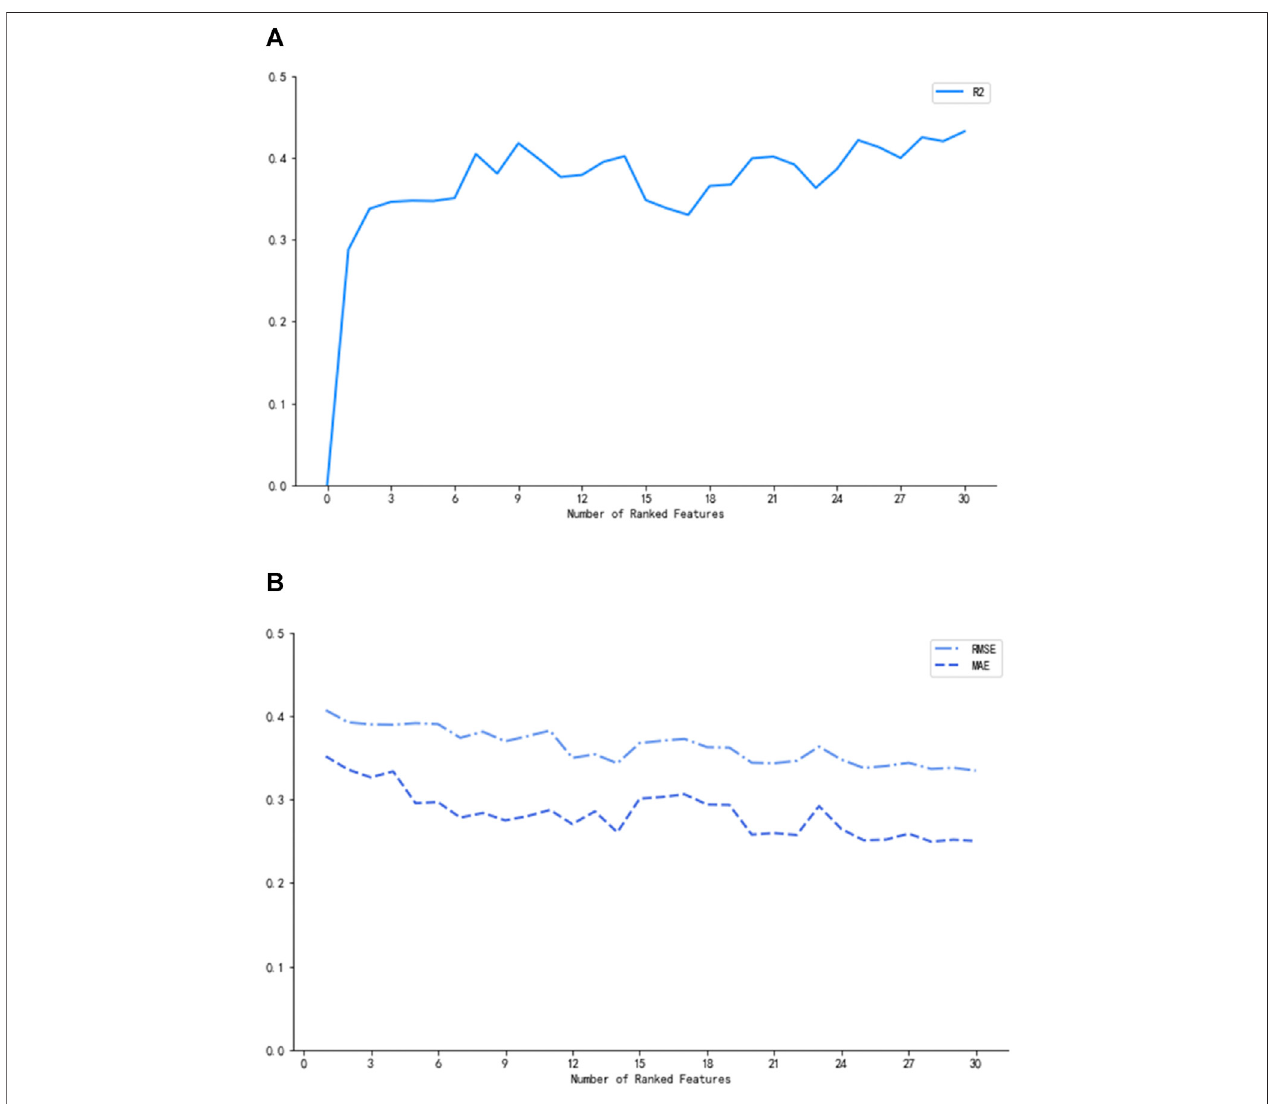
FIGURE 2 | R 2 (A) , MAE, and RMSE (B) corresponding to the number of ranked variables.